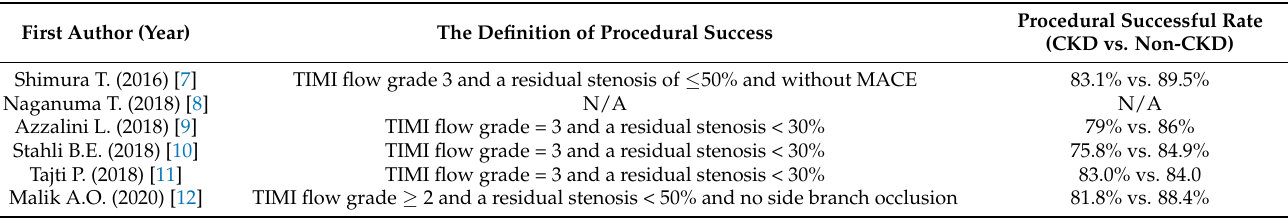
Table 1. Characteristics of the 7 included studies.